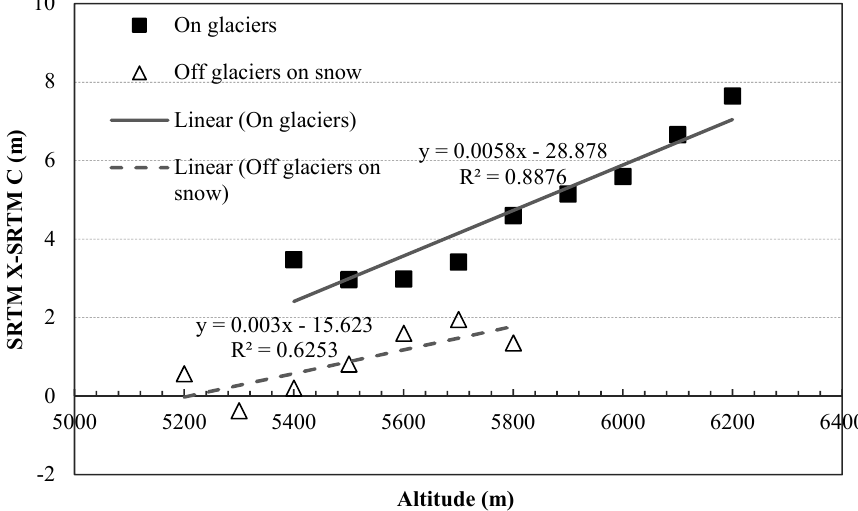
Figure 4. Elevation differences between SRTM X band and C band as a function of altitude.